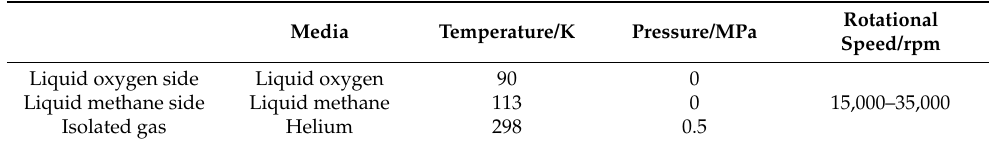
Table 1. Floating-ring gas-isolation seal assembly design conditions.